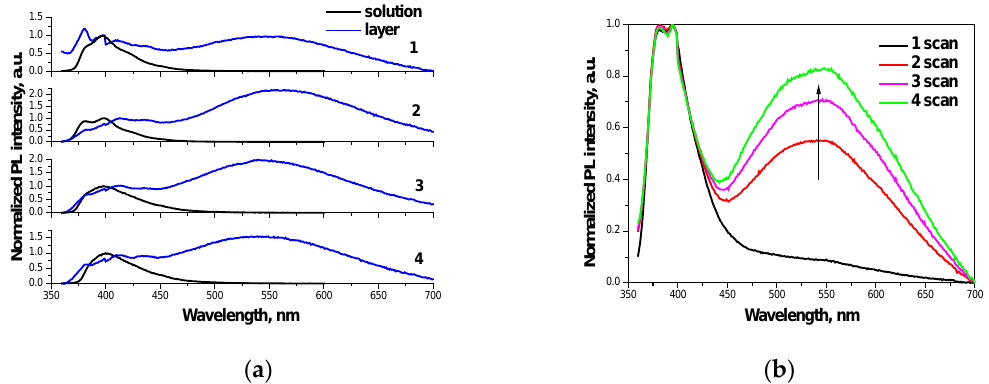
Figure 3. ( a ) PL of the dilute THF solutions and the layers of 1–4 ; ( b ) PL spectra of the solid solution of 1 in ZEONEX 480 after UV-irradiation for 10 min after every measurement.